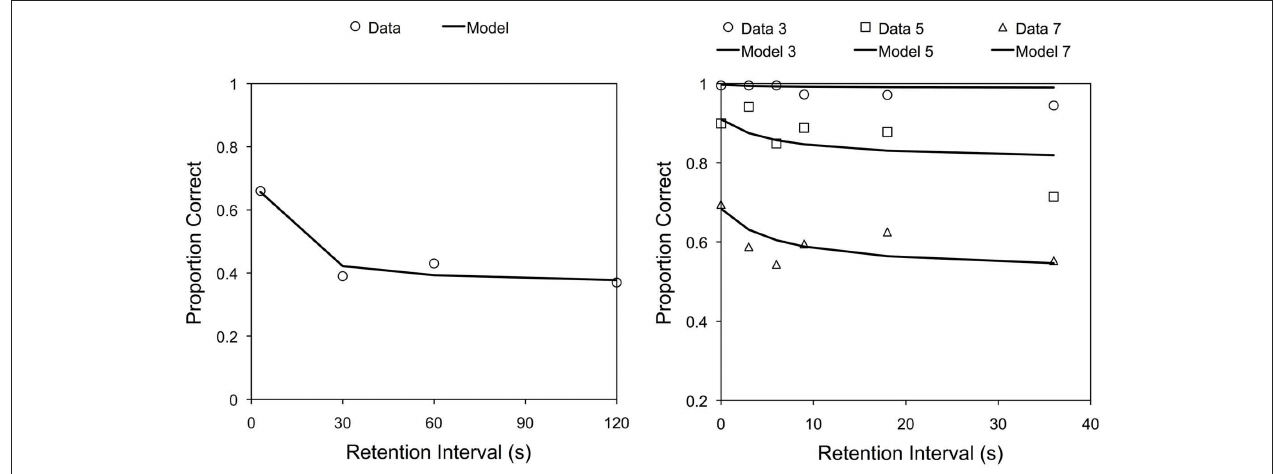
Figure 1 | The data points show the proportion of items correctly recalled in Baddeley and Scott’s (1971) experiment 1 (left panel) and the proportion of items correctly recalled from three-, five-, and seven-item lists in experiment 2 (right panel) as a function of delay. The solid lines show the fit of SIMPLE (see text